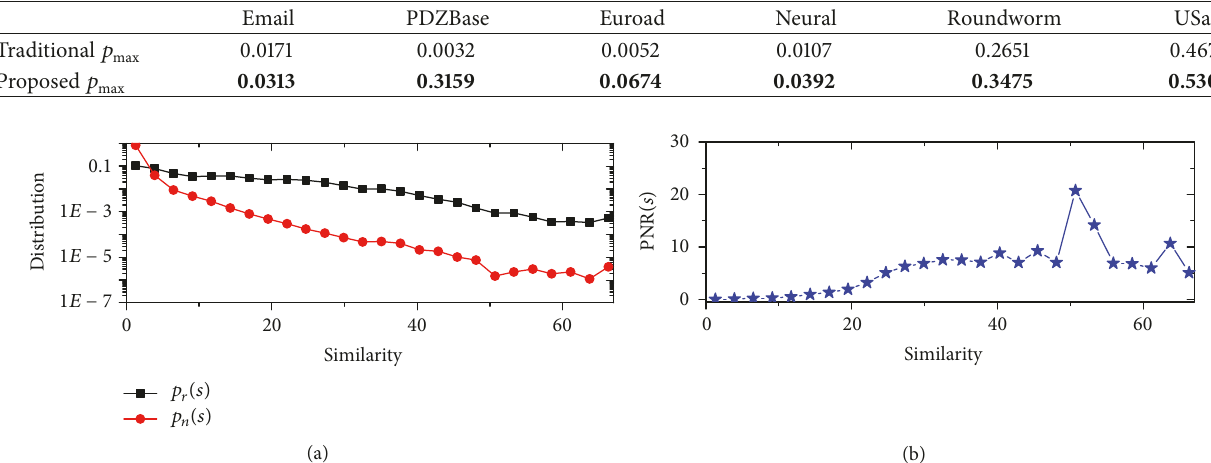
Table 2: Maximal precision comparison of the proposed methods and traditional high-similarity methods for six real-world networks. Traditional precision is obtained by the maximum of traditional methods, that is, max { CN , Jaccard , RA , LP , SPM } . Proposed precision is obtained by our framework, that is, max { PNR CN , PNR Jaccard , PNR RA , PNR LP , PNR SPM } .